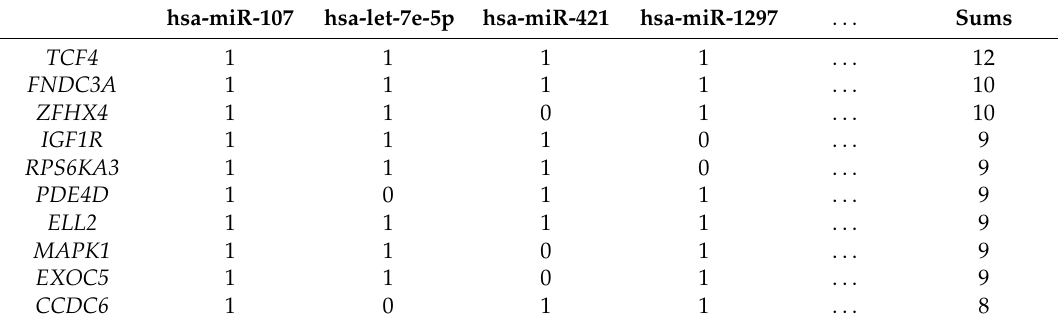
Table 4. Adjacency matrix of top 10 regulated genes.